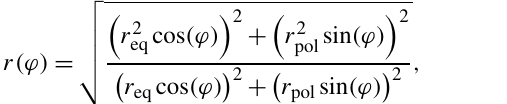
a specified time difference are disregarded in step 7